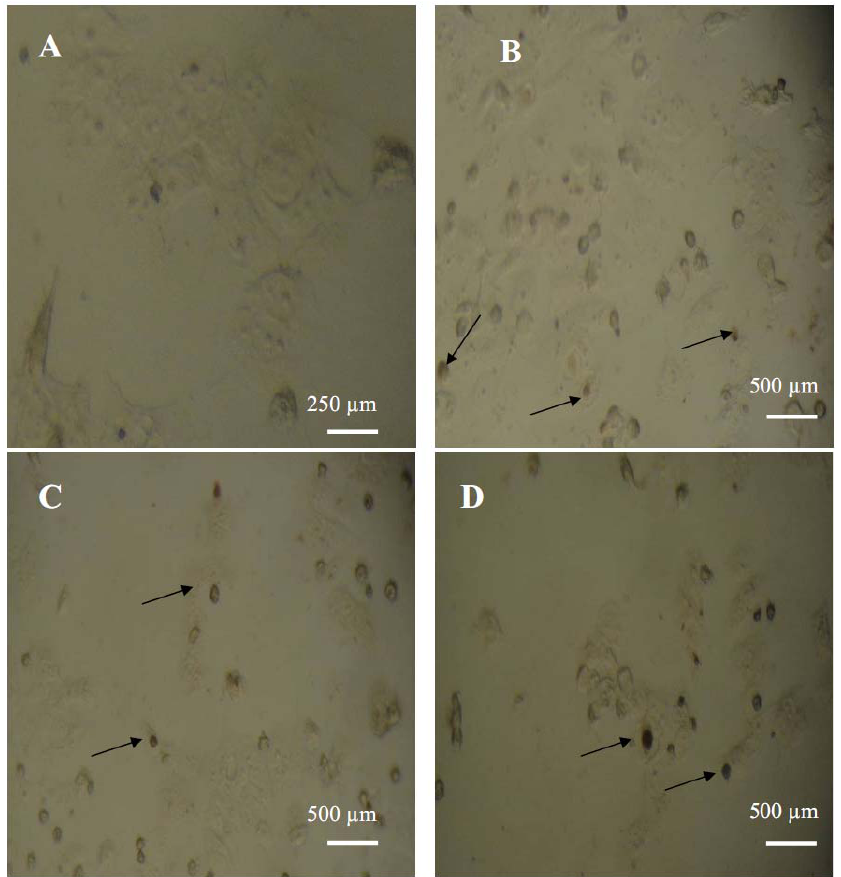
Figure 1. MCF-7 cells assayed by DeadEndTM colorimetric TUNEL system to indicate cell apoptosis. ( A ) Negative control; ( B ) Positive control; ( C ) Cells treated with 15 µg/mL of 3- O -methylquercetin; ( D ) Cells treated with 15 µg/mL of 3, 3 ′ -di- O -methylquercetin. Arrows show dark stained nuclei which indicate DNA fragmentation and nuclear